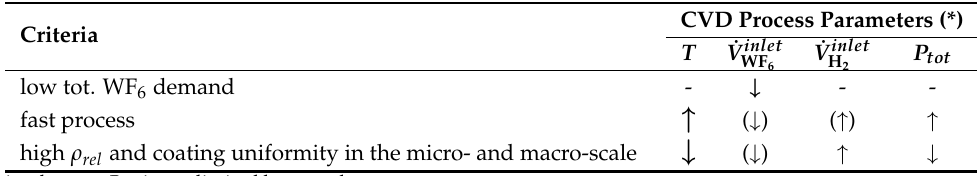
Table 1. Advantageous CVD process parameter trends regarding certain criteria.